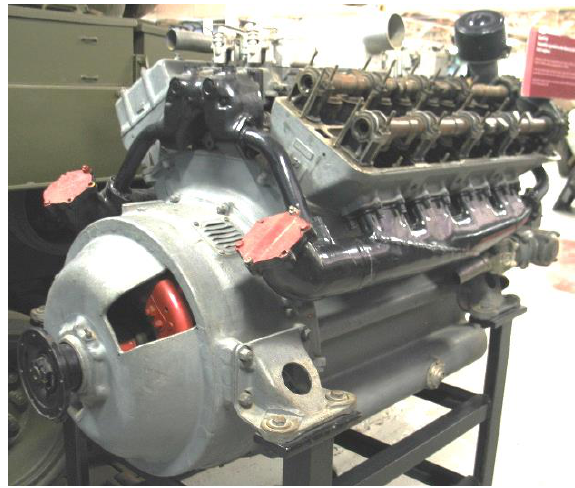
Fig. 9. The Wright Ford GAA engine (The Tank Museum at Bovington Camp in Dorset, photo by the author)